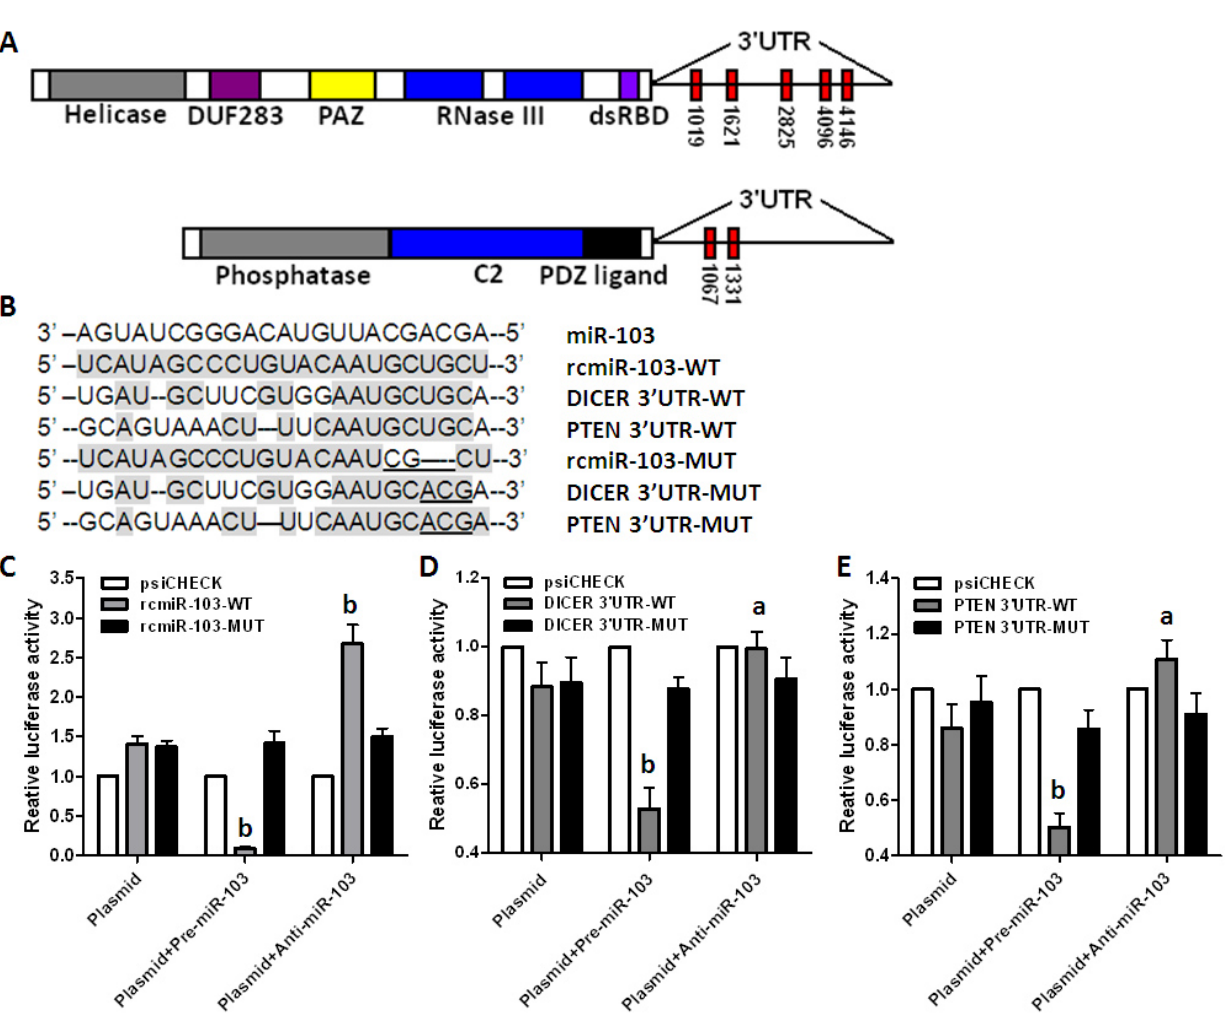
Figure 3. DICER and PTEN are direct target genes of miR-103. ( A ) Schematic gene structure of DICER and PTEN and the miR-103 recognition sites located in the 3'-untranslated region (3'-UTR) are shown as red rectangles; ( B ) Sequence alignment of miR-103 with reverse complementary miR-103 (rcmiR-103-WT), DICER (DICER- 3'-UTR-WT), PTEN (PTEN-3'-UTR-WT), mutant rcmiR-103 (rcmiR-103-MUT), mutant DICER (DICER-3'-UTR-MUT), and mutant PTEN (PTEN-3'-UTR-MUT), mutant nucleotides are underlined; and ( C – E ) Dual-luciferase reporter assay using constructed vectors alone or in the presence of miR-103 precursor or inhibitor was performed. Vectors contain rcmiR-103-WT and rcmiR-103-MUT was used as controls. Renilla luciferase was measured and normalized to Firefly luciferase activity, and the recombinant vector was normalized to empty vector. Data are representative of three experiments. a p < 0.05; b p < 0.01 vs. vector alone